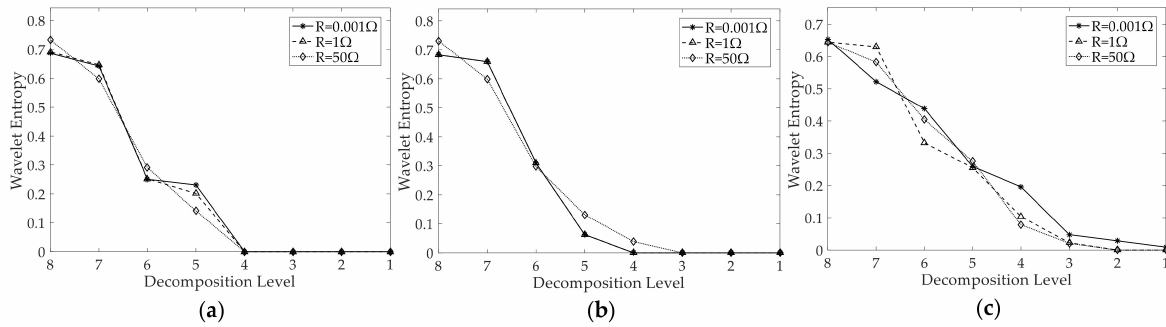
Figure 14. Effect of ground resistor. ( a ) PGF; ( b ) PPF; ( c )